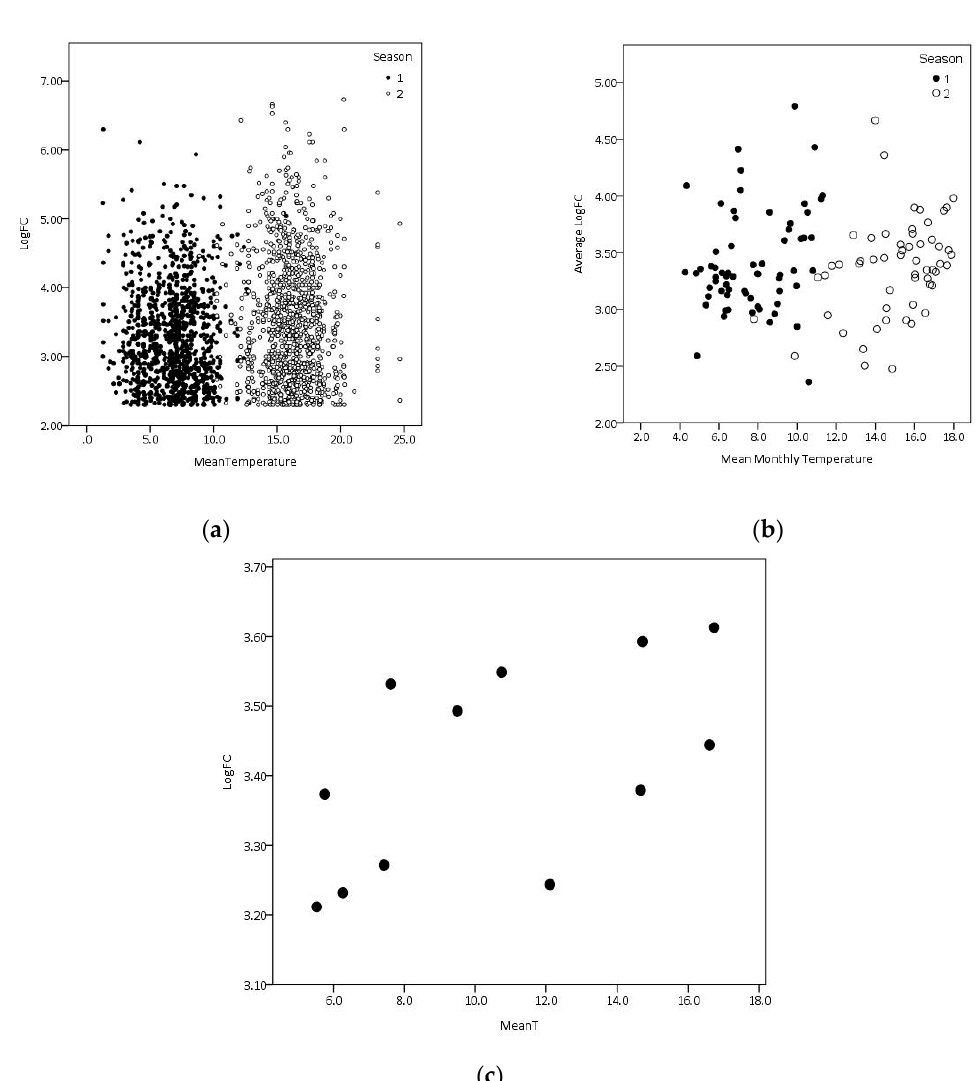
Figure 7. Scatterplots of ( a ) Log FC i,j versus temperature of the day of sampling at each location; ( b ) Log FC y,m versus mean monthly temperature; and ( c ) LogFC m versus mean monthly temperature over the entire period in each month.